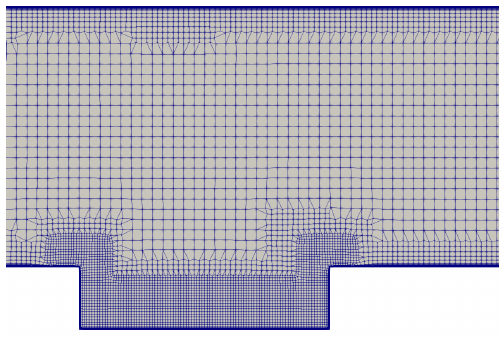
Figure 3. Computational mesh for fluid simulations (case #2).